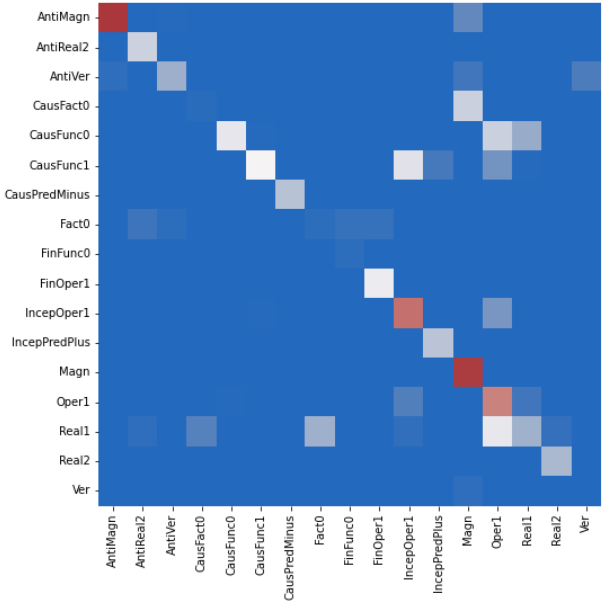
Figure 4. Confusion matrix for the classification of all LFs by our relation model on the Spanish test